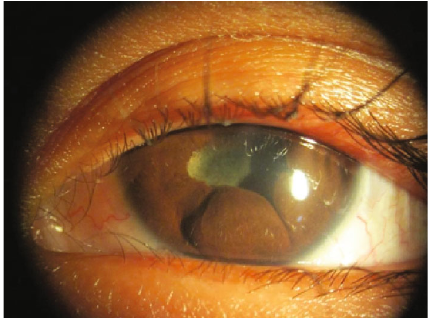
Figure 5: Occlusio pupillae with iris bombes at multiple areas in the left eye.